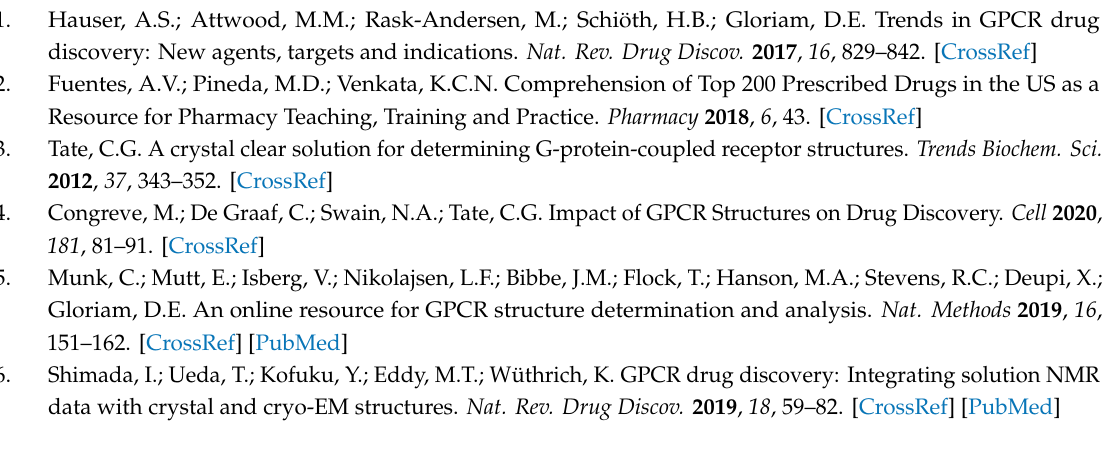
Supplementary Materials: The following are available online, Figure S1: Mutagenesis of methionine residues fails to provide unambiguous assignments for t β 1